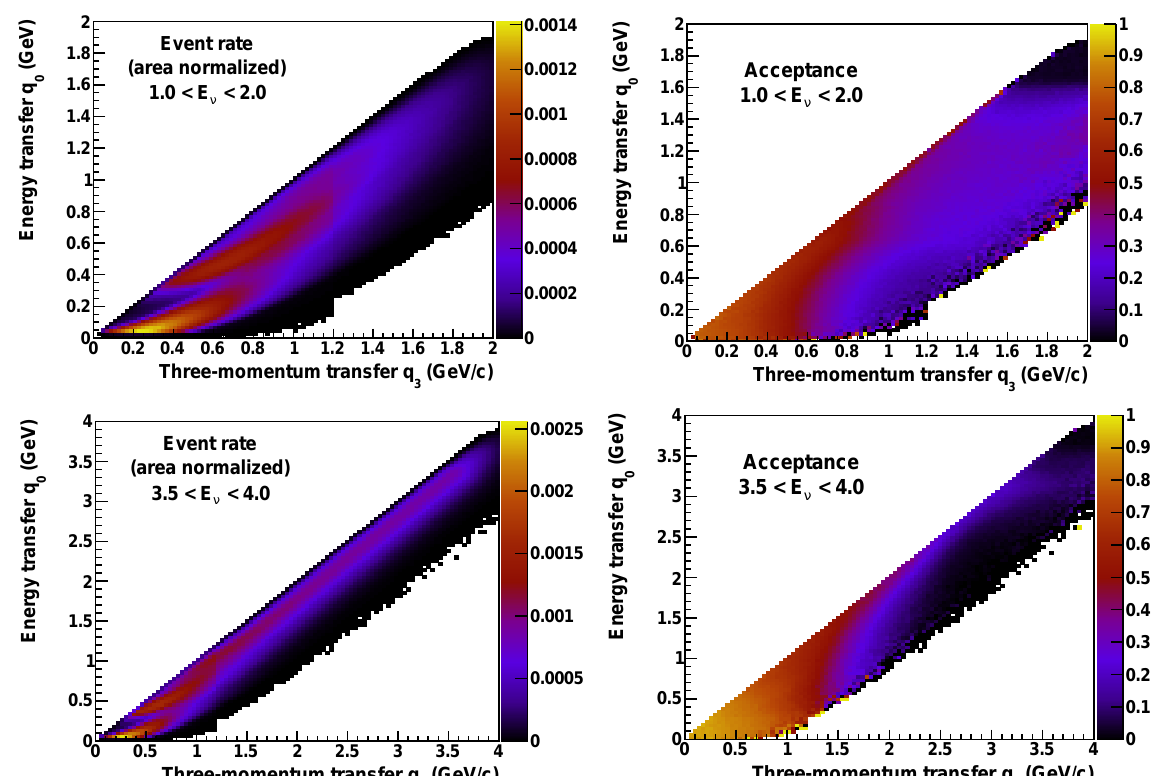
Figure 35. Neutrino acceptance shown as a function of energy transfer and momentum transfer ( q 0 and q 3 ) to the target nucleus. The figures show the event rate ( left ) and the acceptance ( right ) for reconstructing the muon and containing the hadronic system. The top row was made for neutrinos with true neutrino energy between 1.0GeV to 2.0GeV just below the flux peak, and the bottom was made for neutrinos between 3.5GeV to 4.0GeV on the falling edge of the